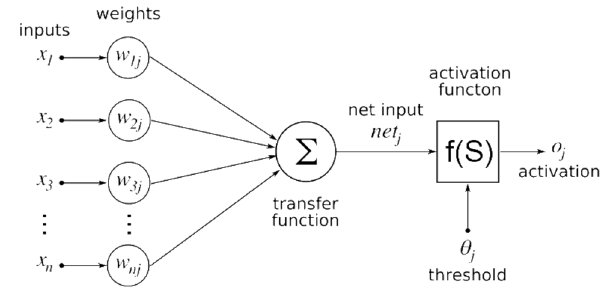
Figure 3. Neuron node model diagram.